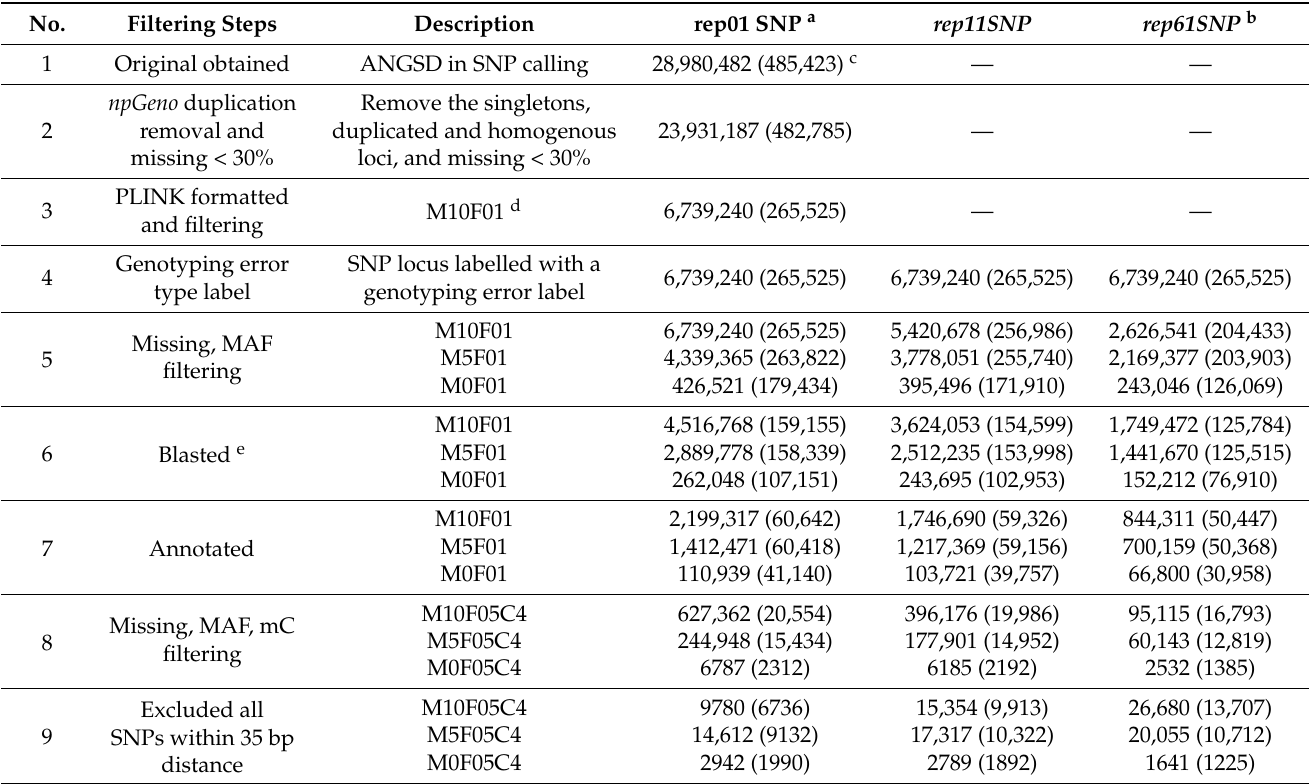
Table 2. SNP filtering process and SNP count and contig numbers with and without one or six replicates